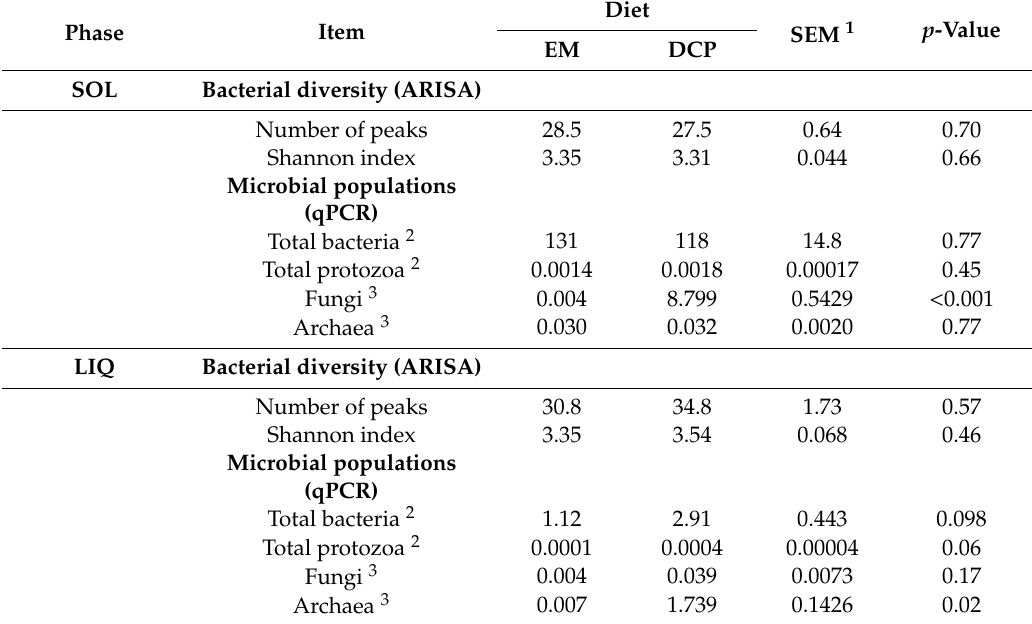
Figure 1 represents the PCoA plot based on the Bray–Curtis dissimilarities. Percentages of variance explained by the principal coordinates 1 and 2 were 34.8% and 24.9%, respectively. The plot shows that coordinate 2 separated the samples according to the diet, whereas coordinate 1 separated them according to the digesta phase. Samples from DCP-fed fermenters showed greater separation among them than those fed the EM diet. Regardless of the diet, samples from the SOL phase were placed closer together than those from the LIQ